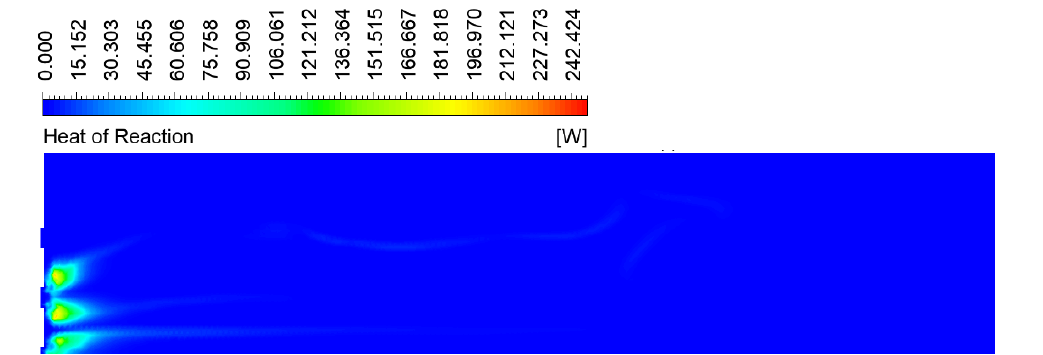
Figure 7. The distribution of combustion heat release rate in x-y plane. The heat release rate distribution of each injector within 2 ms is extracted, and then the effective parameters are obtained according to the flame transfer function introduced in Section 2.1.2. This duration is chosen to cover at least one full cycle of the three frequency simulations. Figure 8a,b are, respectively, the amplitude–frequency characteristic curve and the phase–frequency characteristic curve of flame transfer function, taking the central injector as an example.